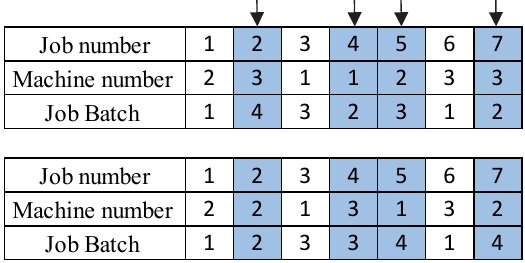
Fig. 8 indicates the mechanism of mutation operator for machine assignment to the 𝑖 (cid:3047)(cid:3035) job and batching the jobs.